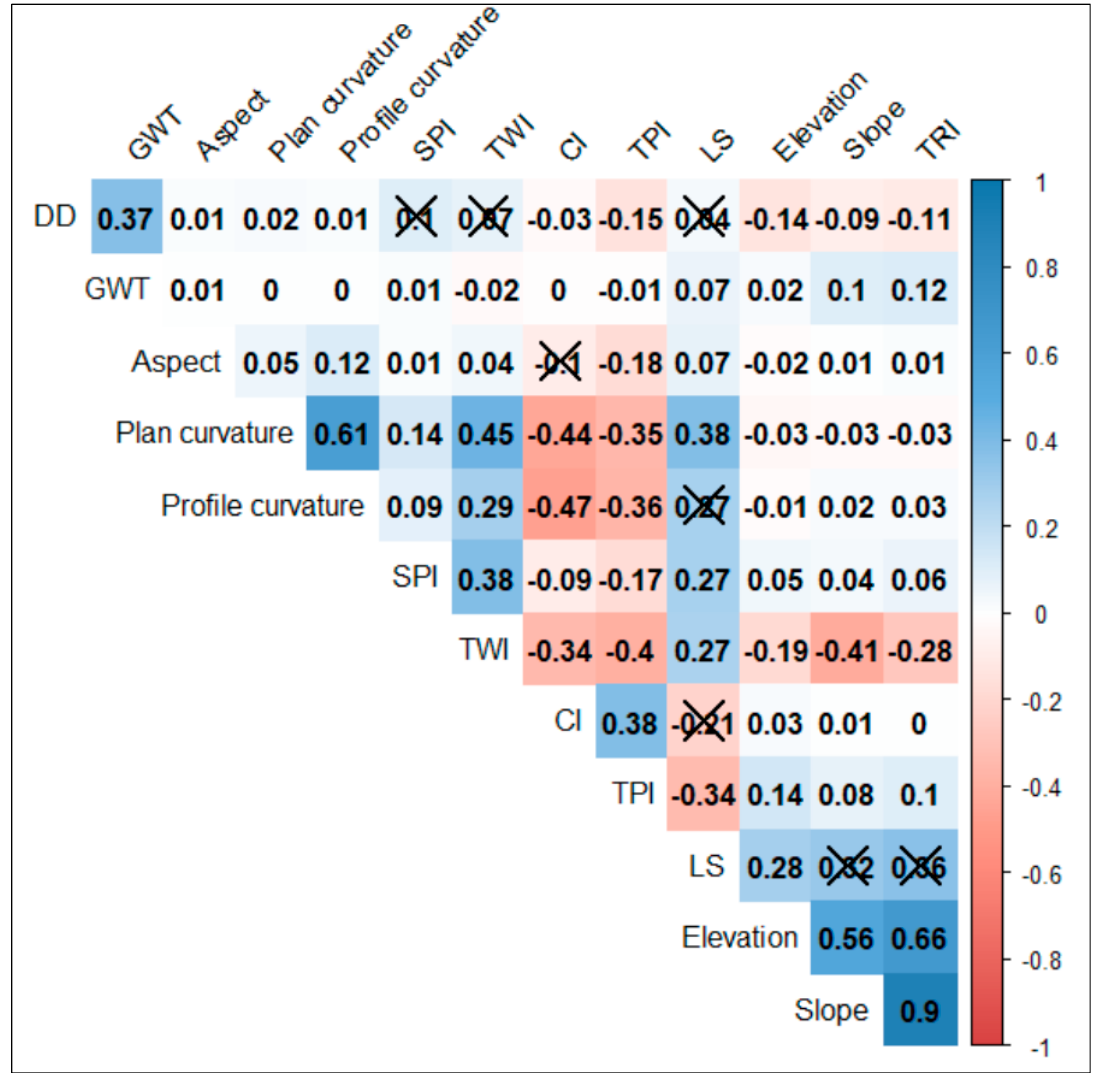
Figure 3. Correlation matrix for the 13 quantitative gully-erosion predictor factors. Crosses are added for correlations having p -values >0.01 or when the correlation is